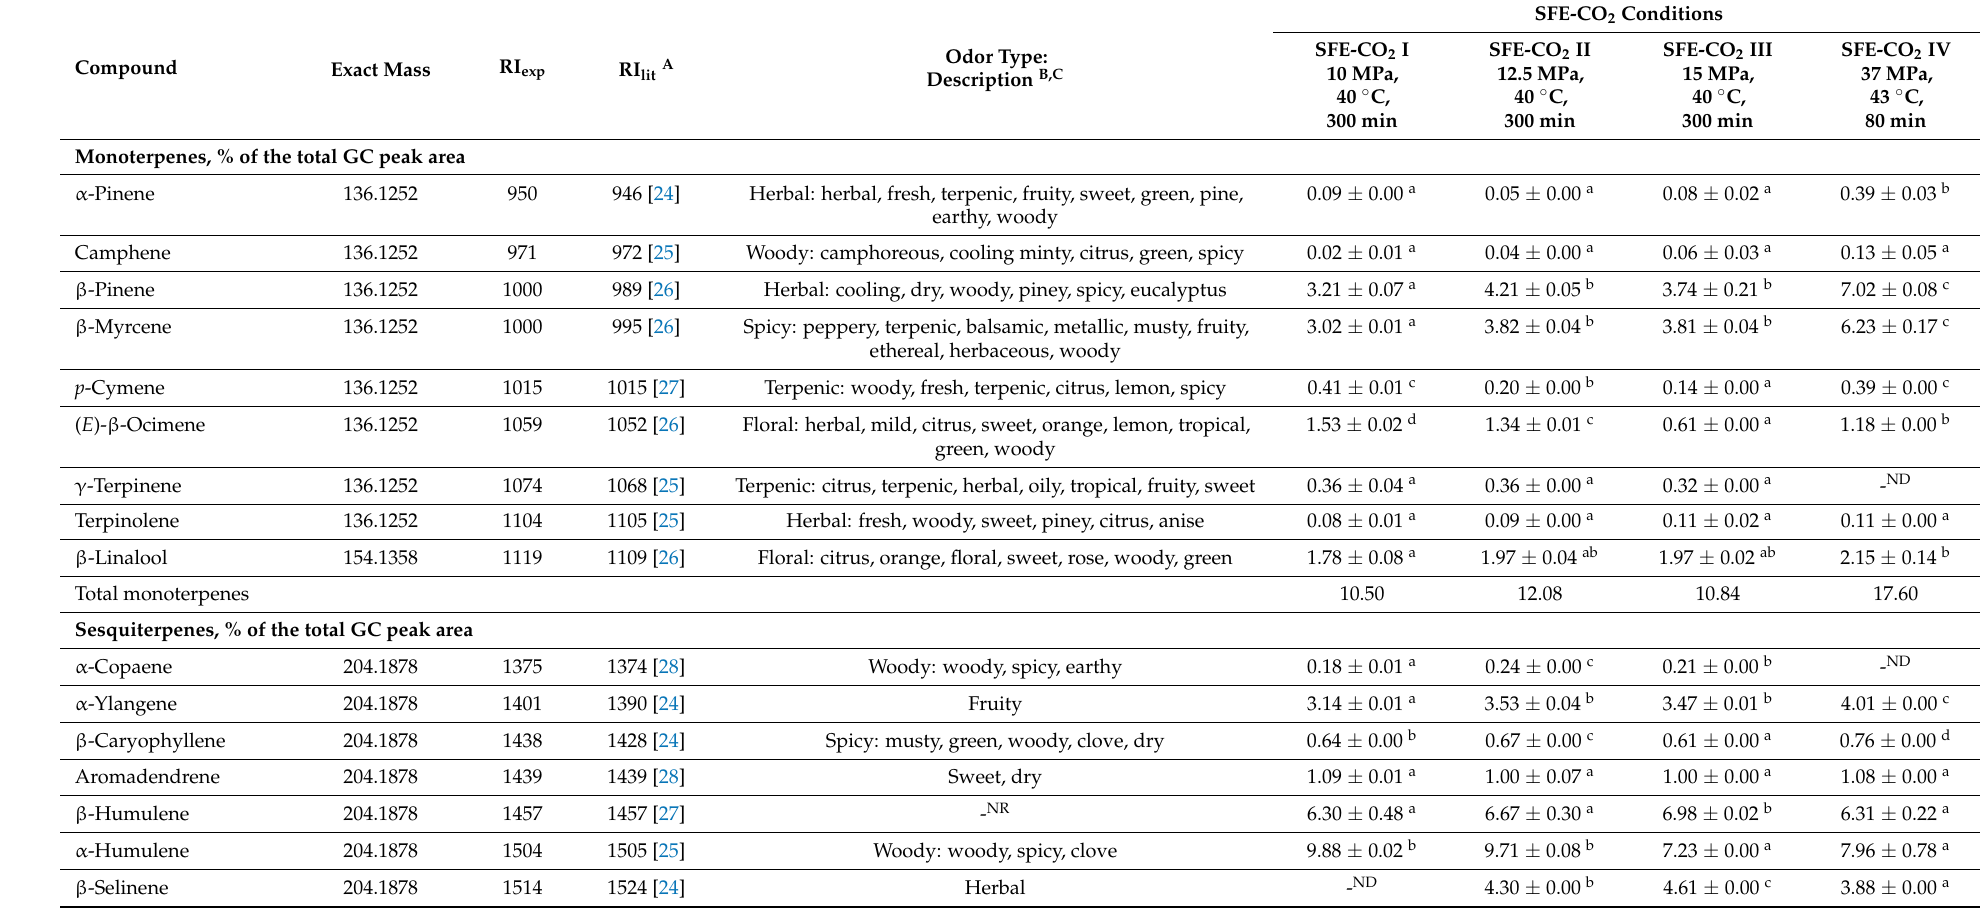
Table 5. Volatile compound composition (% of the total GC peak area) of Ella hop SFE-CO 2 extracts obtained under different experimental